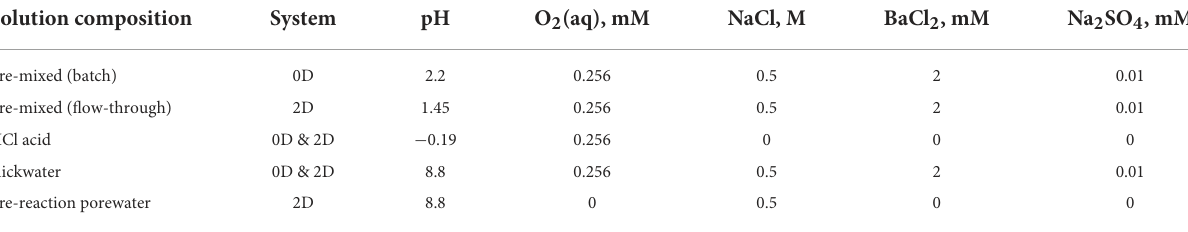
TABLE 1 Solution compositions used in this study.